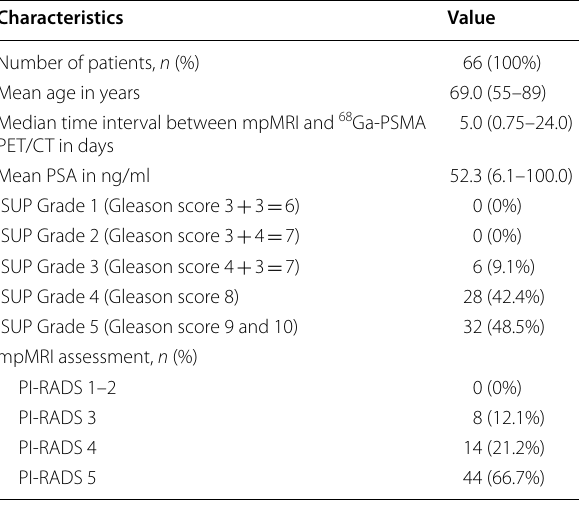
Table 2 Characteristics of the high-risk prostate cancer patient population ( n =